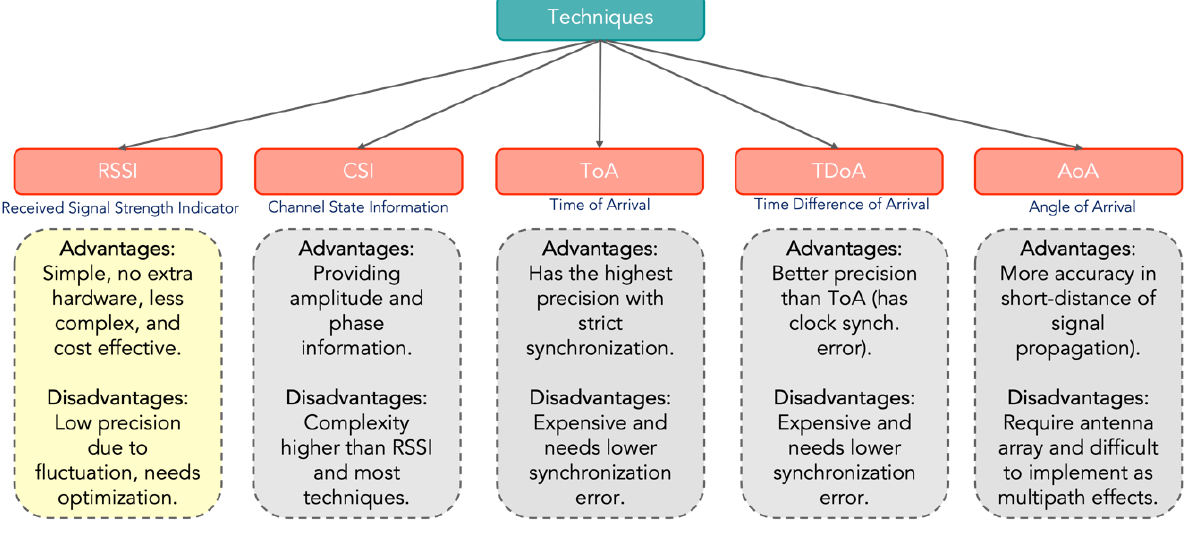
Figure 1. Distance measurement technique.